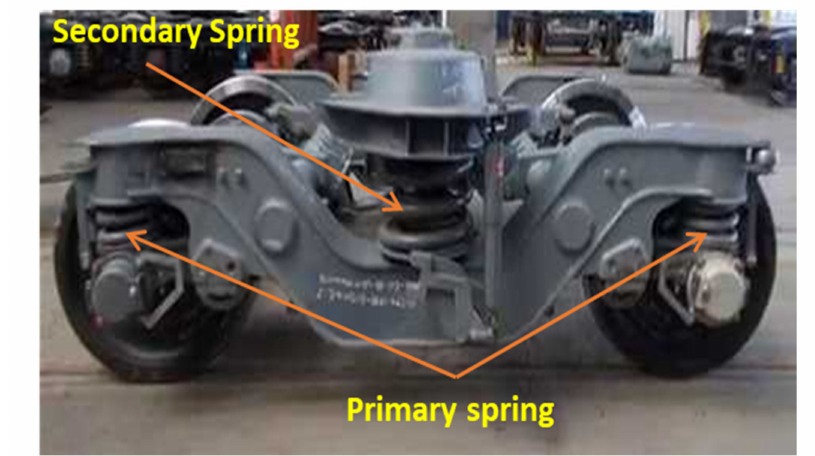
Figure 1. Fait bogie with primary and secondary spring.